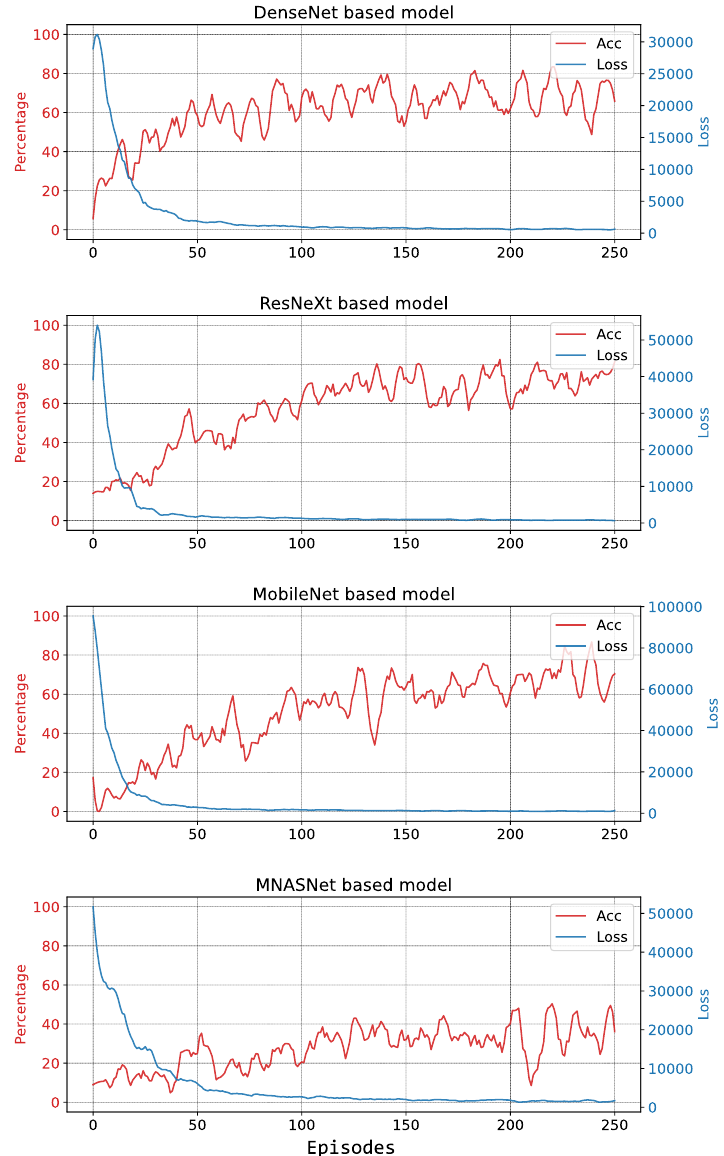
Figure 8. Evolution of loss and accuracy during 250 episodes during the second training session with demonstration through shaping. The blue line shows loss data smoothed using a third order